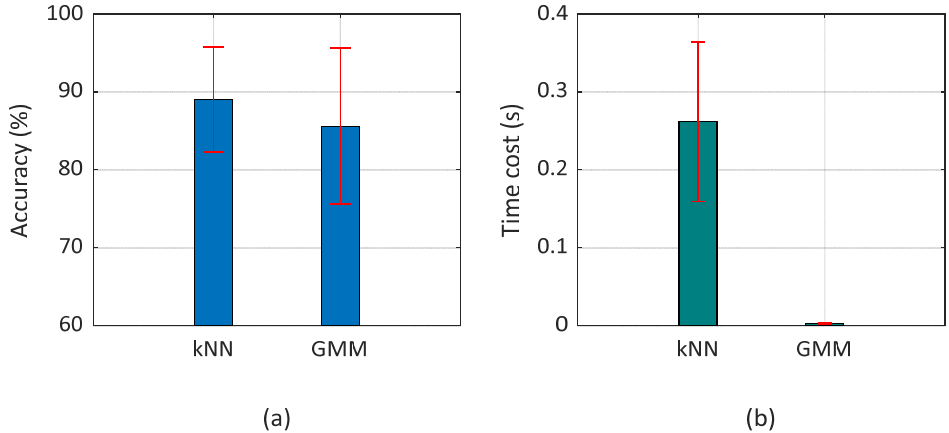
Figure 1. Comparison of k-nearest neighbor (kNN) and Gaussian mixture model (GMM) for movement recognizing. ( a ) Comparison of classification accuracy. The K in kNN is six, and the number of Gaussian components in GMM is three; ( b ) Comparison of average time cost for recognizing one movement.